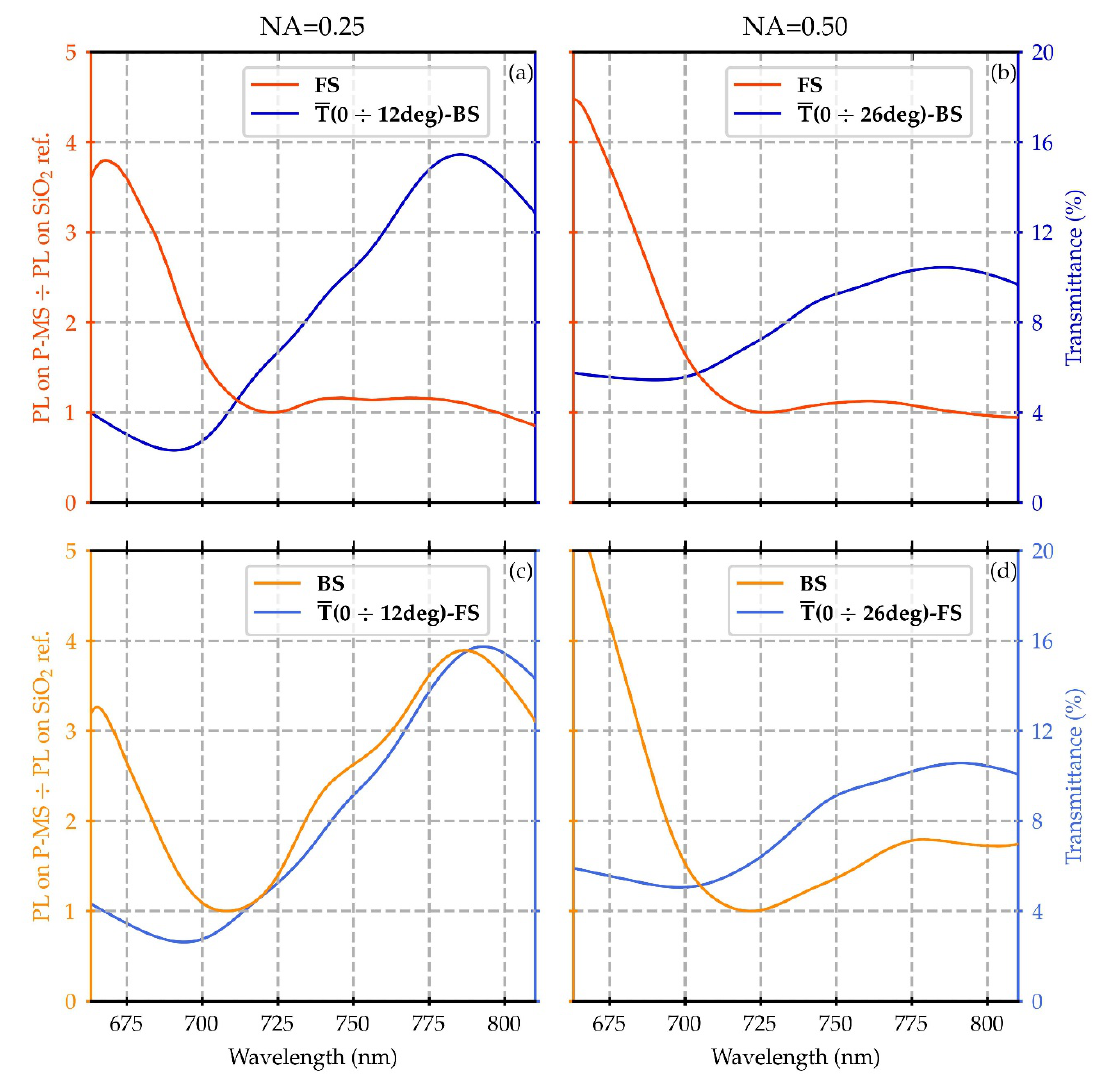
Figure 7. Comparison between the ratio of the normalized photoluminescence spectra of ATTO700 measured on the plasmonic metasurface (P-MS) and on the SiO 2 reference with the transmittance signals averaged over the angles lying within the NA value. The first row refers to the positioning of the detector at the front side (FS) for NA = 0.25 ( a ) and NA = 0.50 ( b ). In the second row, the positioning of the detector is at the back side (BS) of the structure for NA = 0.25 ( c ) and NA = 0.50 ( d ).